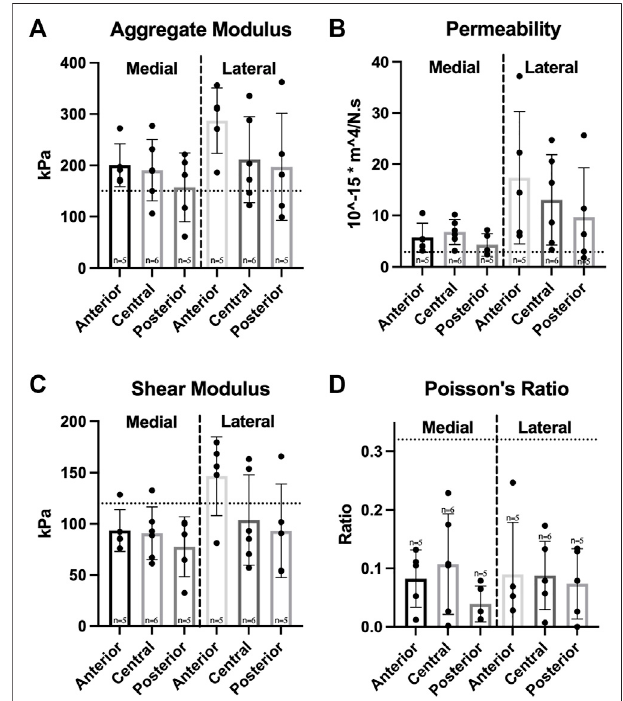
FIGURE 4 | Tensile properties of Yucatan minipig knee menisci. (A,B) Young ’ s Modulus and UTS of medial and lateral menisci are shown for the circumferential and radial directions, respectively. No signi fi cant difference wasseenincircumferentialstiffnessandstrength; (C,D) radialstiffnessin the anterior region of the medial meniscus was signi fi cantly higher than the posterior region, though no signi fi cant difference was seen in radial tensile strength. All data are presented as means ± standard deviations. Statistical signi fi cance is indicated by bars not sharing the same letters within the same meniscus; additionally, horizontal dotted lines on the Y-axis represent human meniscusvaluesfromtheliteratureforcomparisontotheminipig(Tissakhtand Ahmed, 1995; Makris et al., 2011).